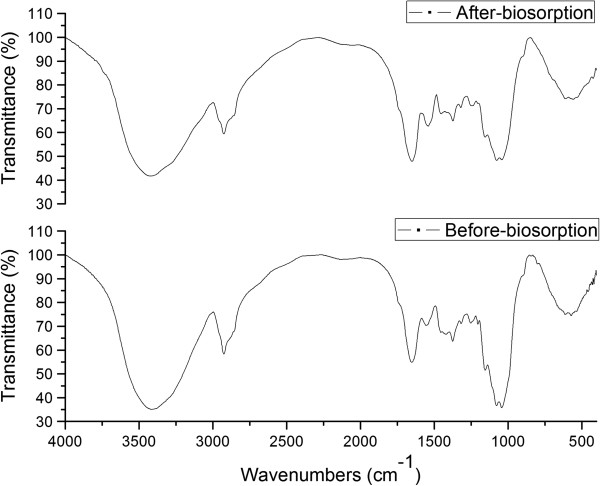
FTIR spectrum of biosorbent (before-biosorption and after-biosorption).